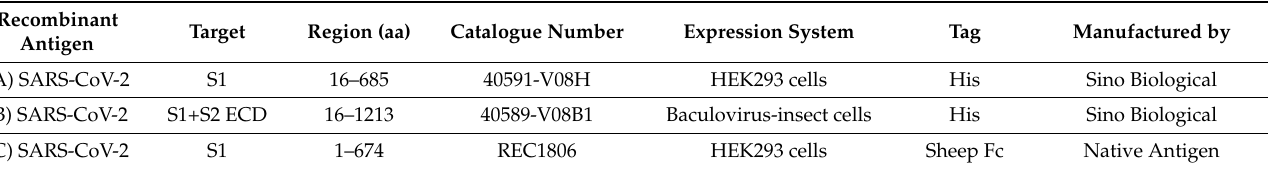
Table 1. Evaluated recombinant SARS-CoV-2